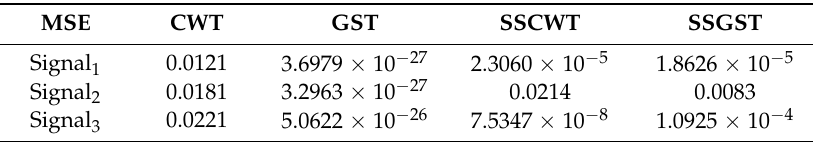
Table 2. The mean square error (MSE) values of synthetic examples based on the Synchrosqueezing Generalized S-transform (SSGST) and the other